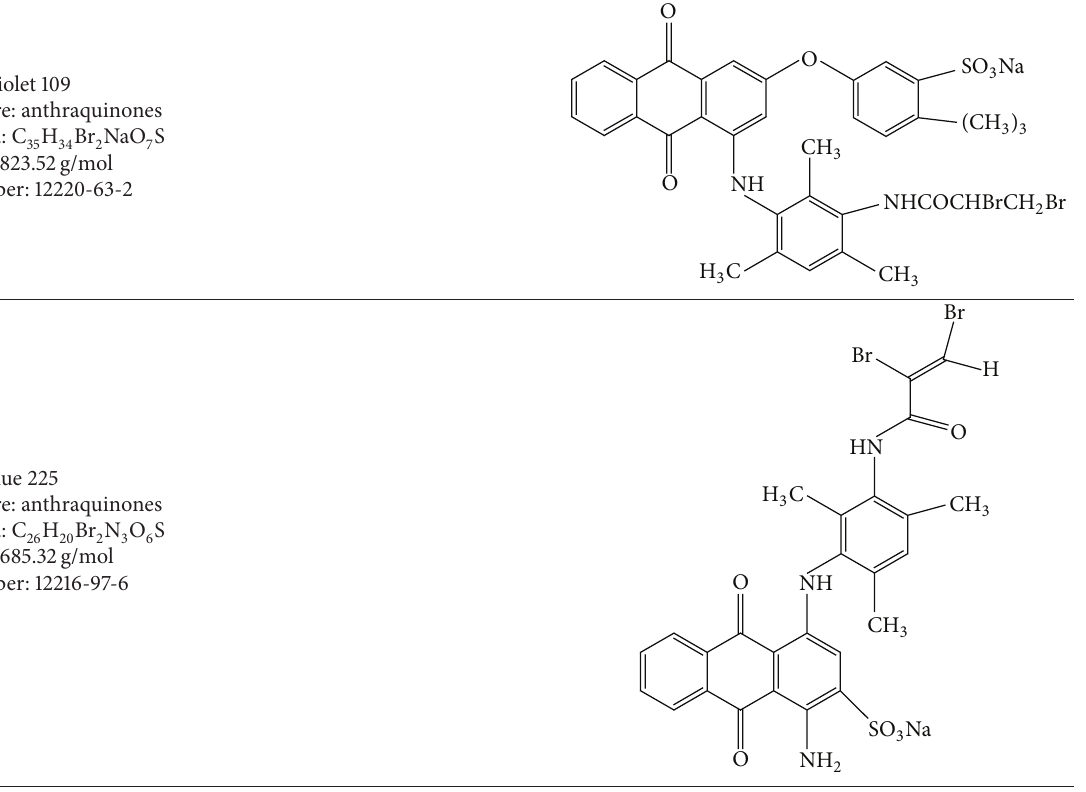
Name: C.I. Acid Violet 109 Molecular structure: anthraquinones